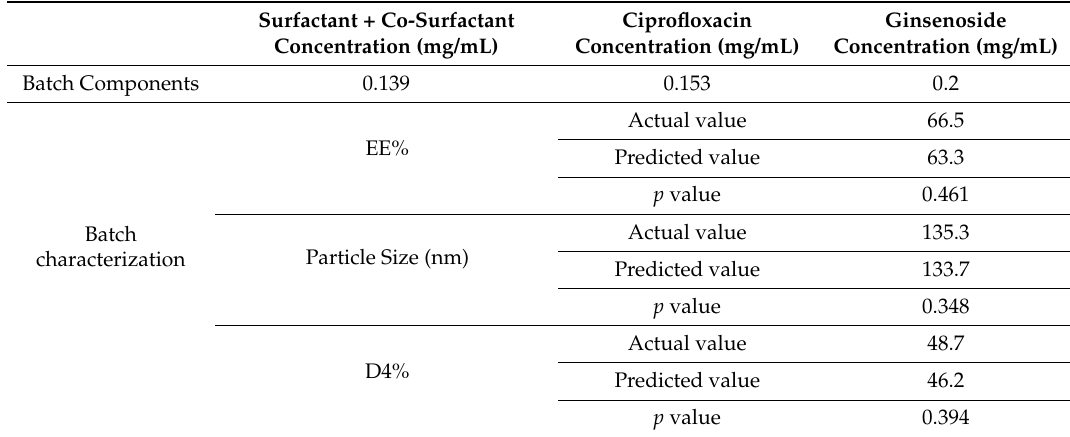
Table 2. Optimized batch components, predicted and measured values of EE% and particle size. Surfactant +